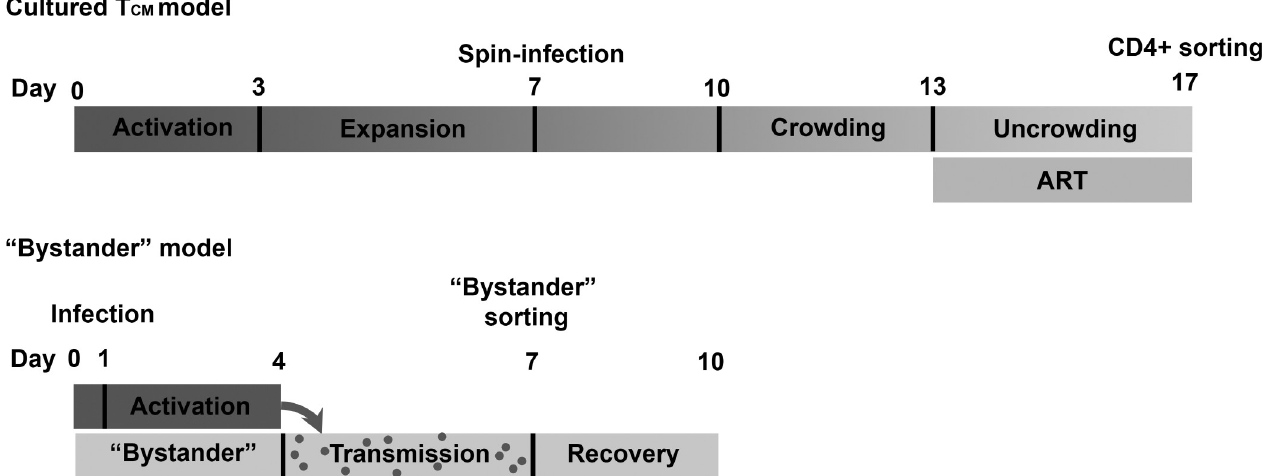
Fig 1. Comparison of the time-line of latency establishment between cultured T CM and bystander models. Cells during activation stage are depicted with darker grey color. Resting cells are presented in light grey. Gradient of color for the cultured T CM model represents gradual return from activation to quiescence. Major steps during model set-up (such as infection and sorting) are indicated above the time-line.